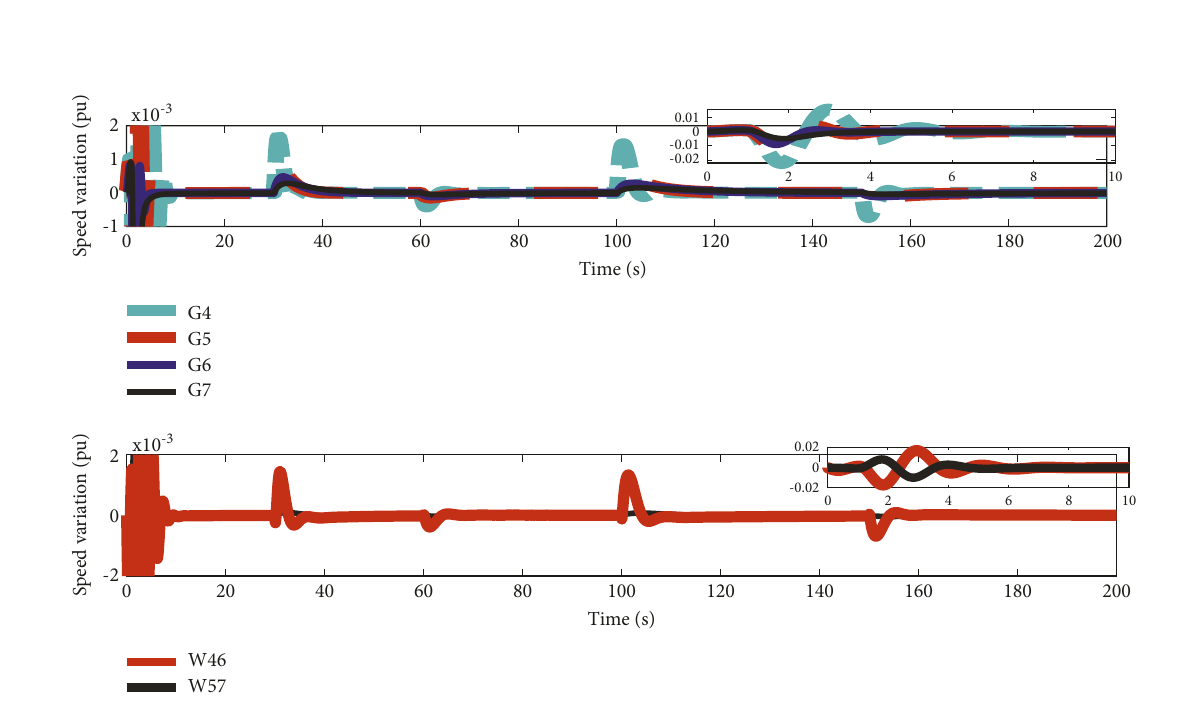
Figure 22: Angular frequency variation of G